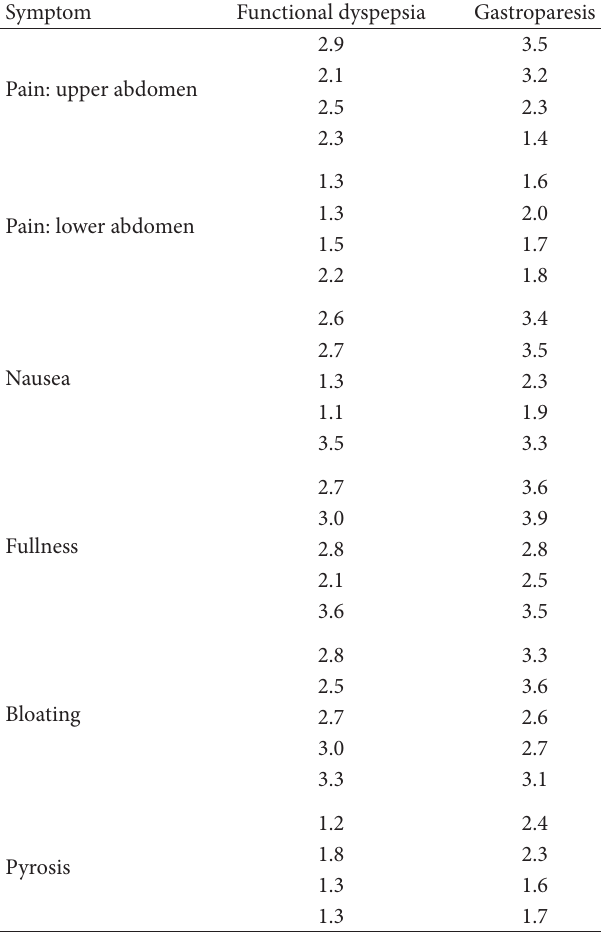
T 1: Comparison of symptom severity scores obtained with a standardized questionnaire (PAGI-SYM) in patients with gastro- paresis and functional dyspepsia